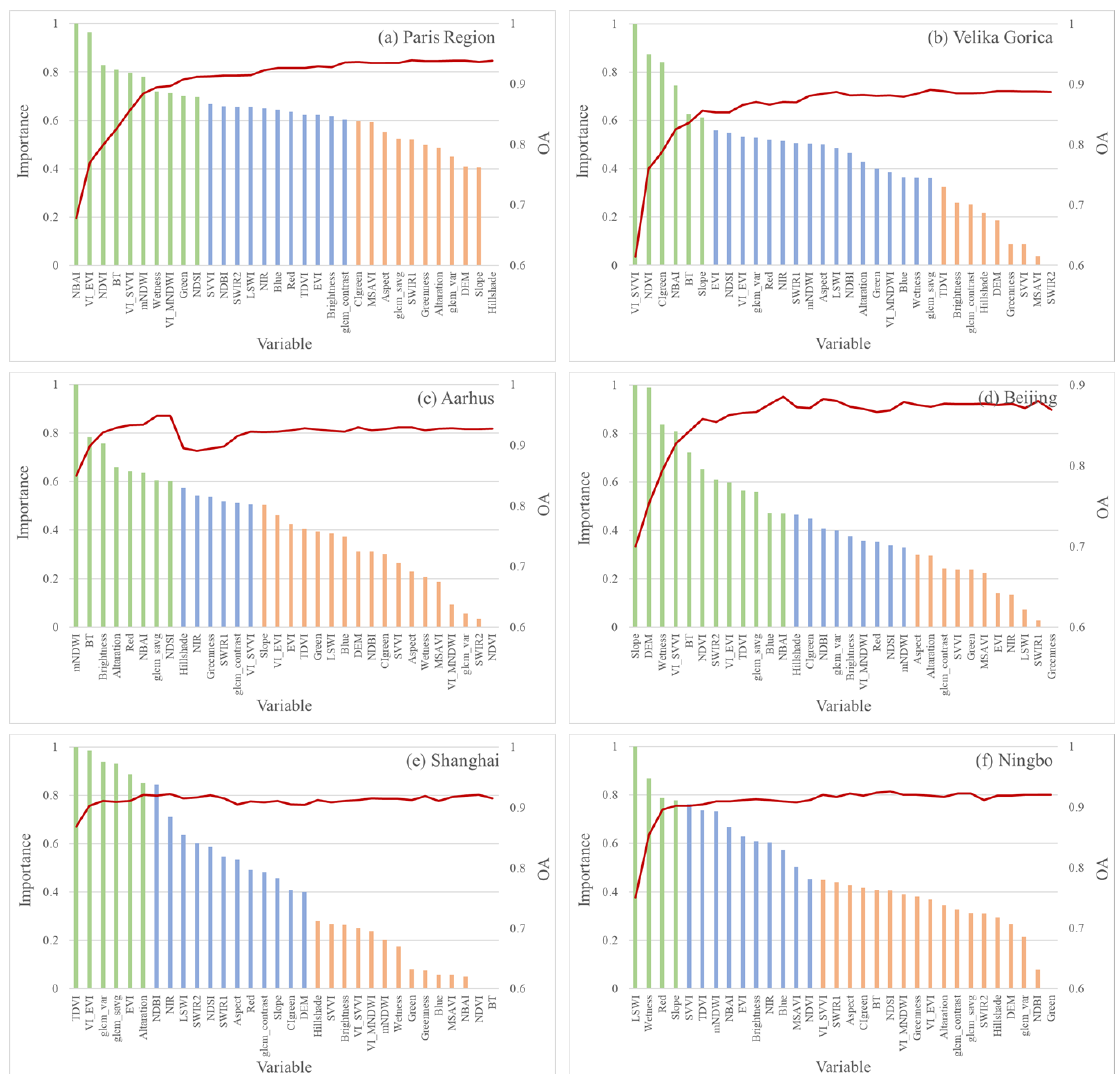
Figure 3. The bar chart represents normalised importance scores for the 32 input variables based on GINI. The red line represents the OA of the classification in relation to the reduction of the number of input variables.